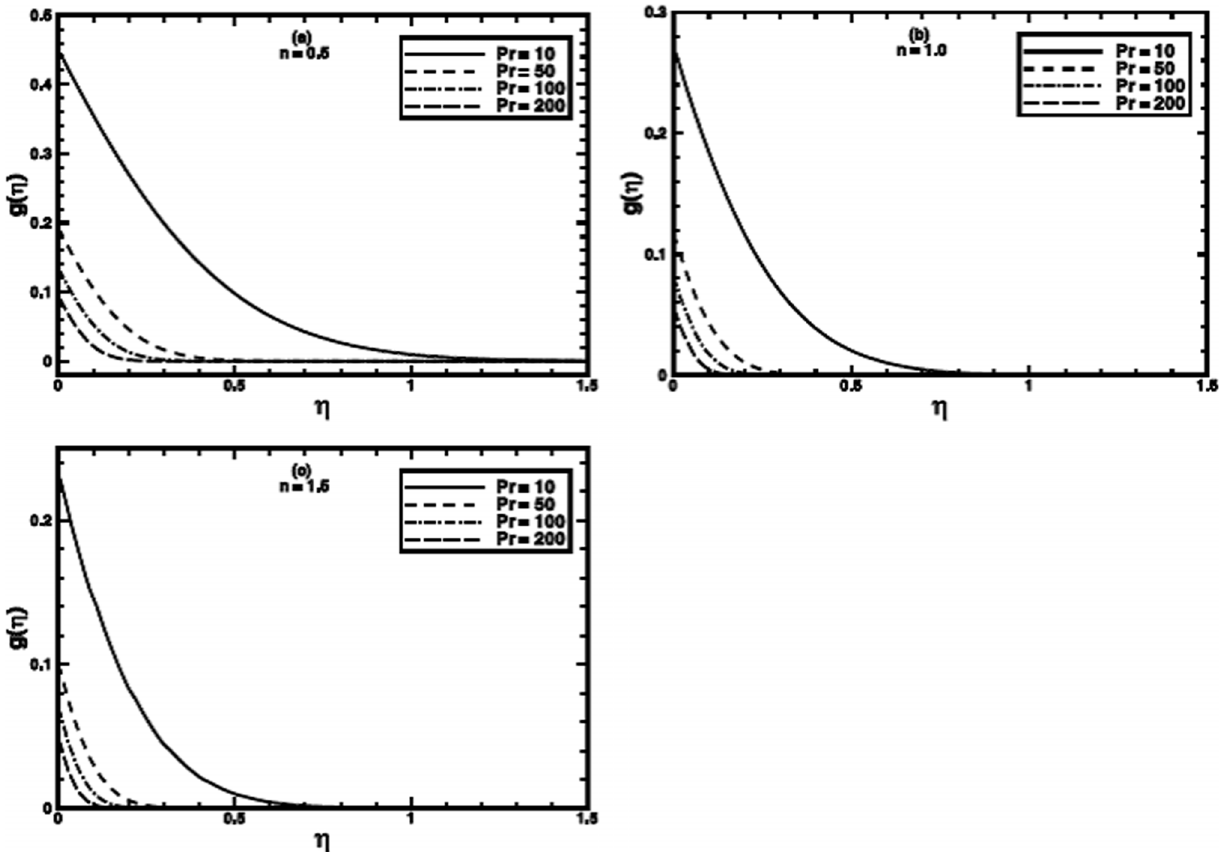
Figure 10. The temperature profile g g ð Þ in the PHF case for different values of the Prandtl number Pr when s ~ 1 : 5 , m ~ 1 and A ~ 1 are fixed.